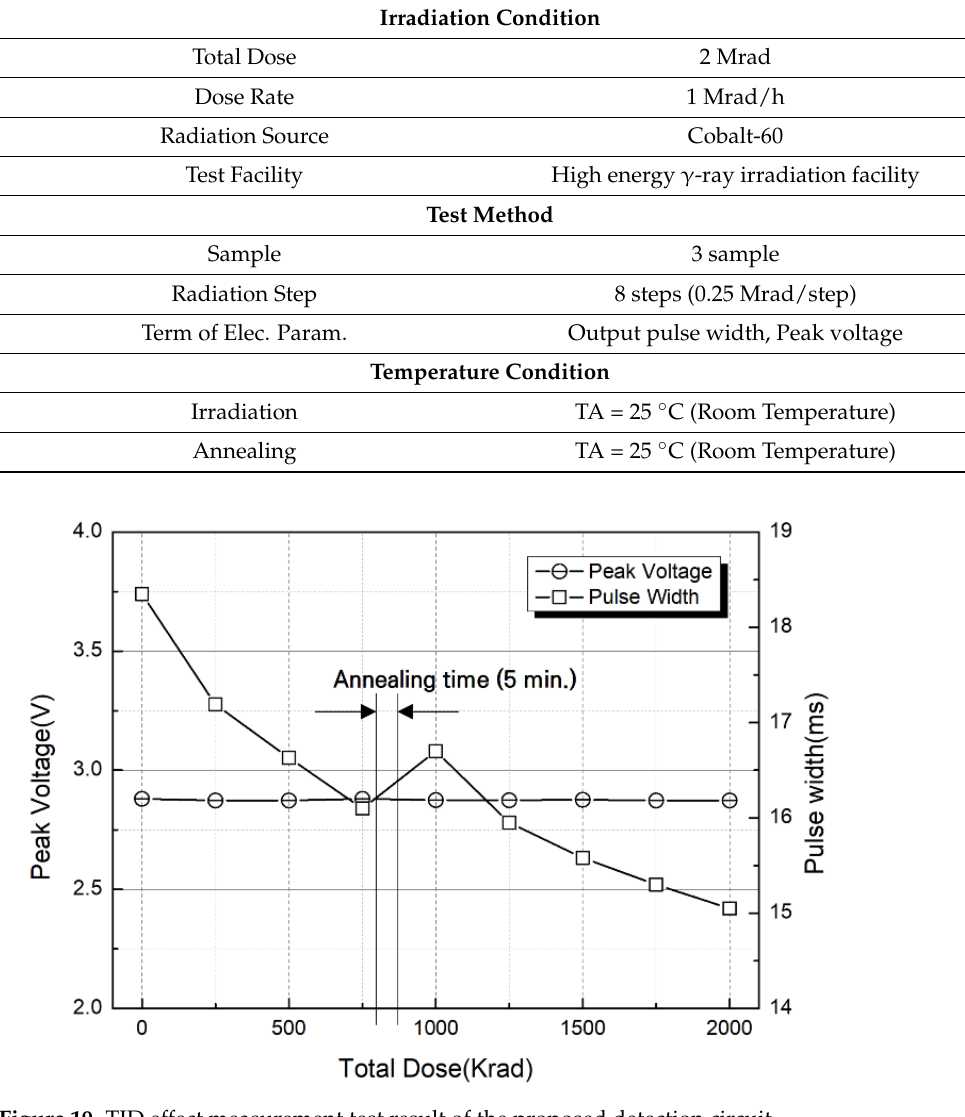
Figure 19. TID effect measurement test result of the proposed detection circuit.